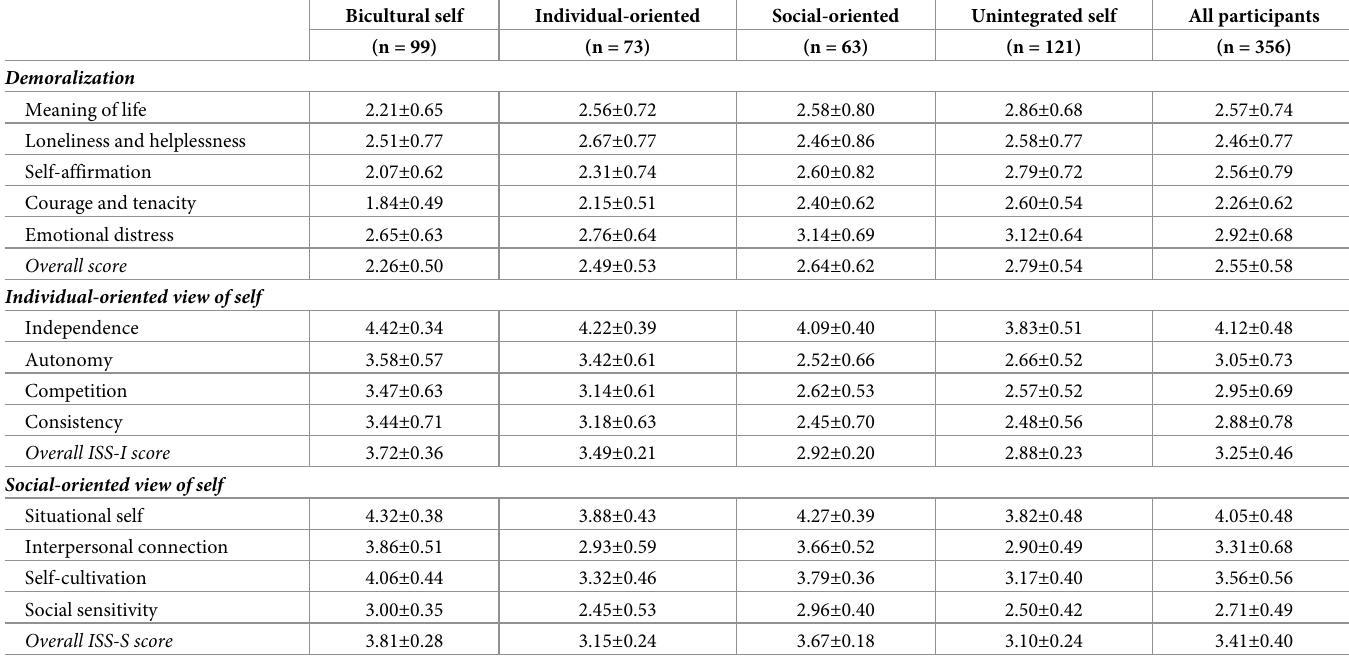
Table 2. College students’ demoralization and individual/social-oriented view of